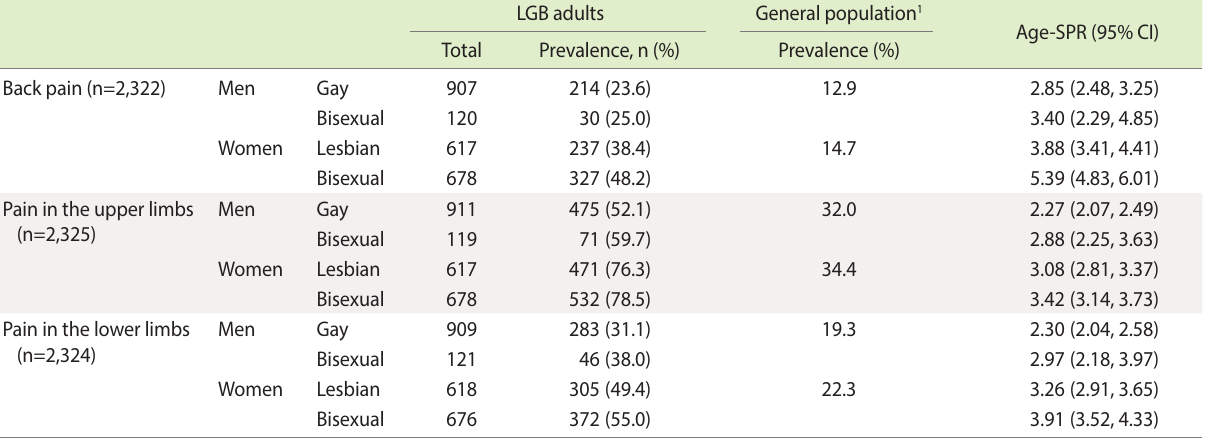
Table 3. SPR of musculoskeletal pain between LGB population (2016) and the general population (2014) 1 in